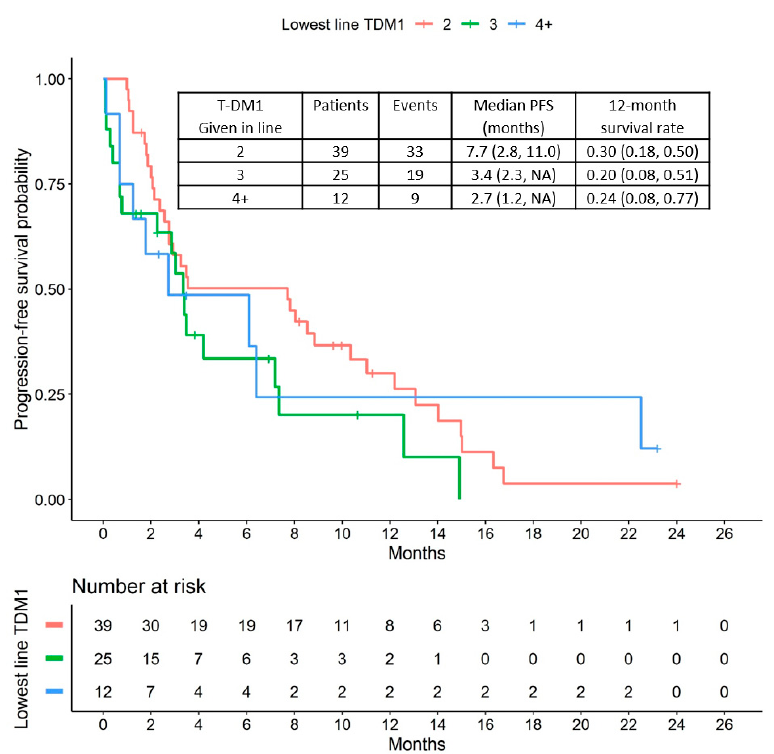
Figure 2. PFS relative to T-DM1 treatment lines.